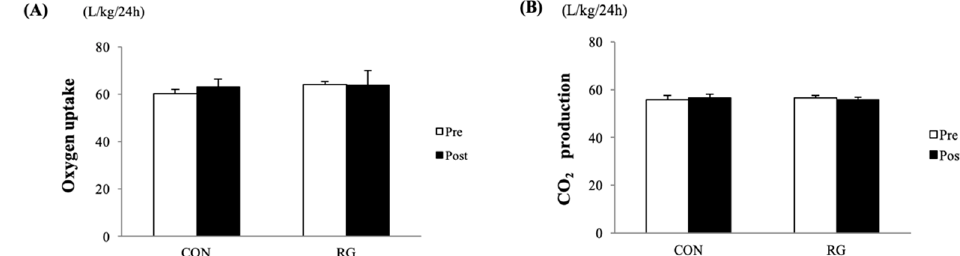
Figure 1. Comparison of the sum of oxygen uptake ( A ) and CO 2 production ( B ) for 24 h between the two groups before and after 2 weeks of red ginseng (RG) intake. Values are presented as the mean ± SE. Table 3. Resting metabolic rate and active period (dark phase) after 2 weeks of red ginseng (RG) intake. CON RG RMR (kcal / day) 4.44 ± 0.37 Values are presented as the mean ± SE.